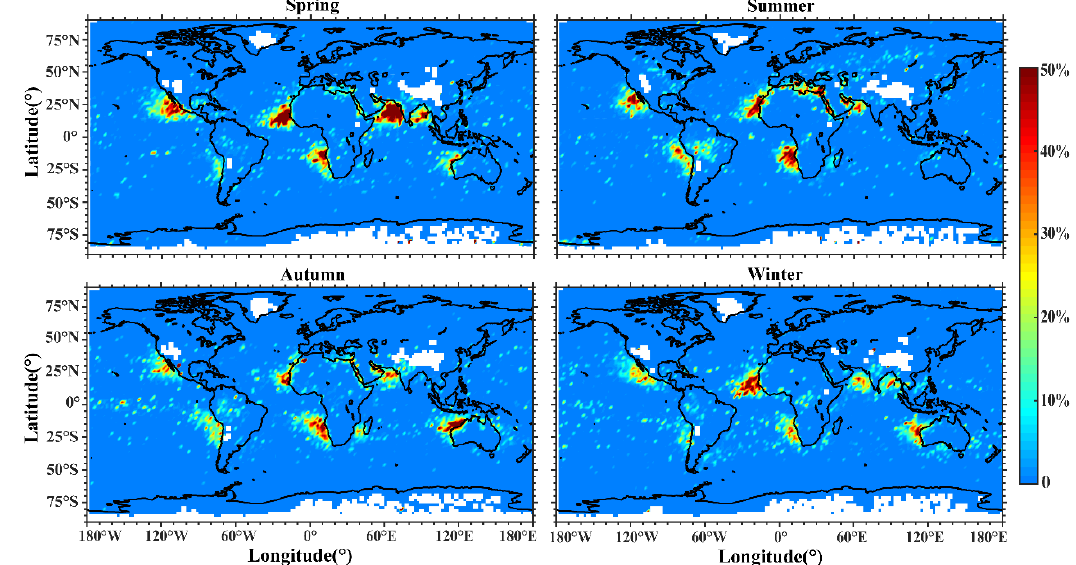
Figure 5. Distribution of the trapping layer occurrence rate with season variations. The blank grids represent that there is